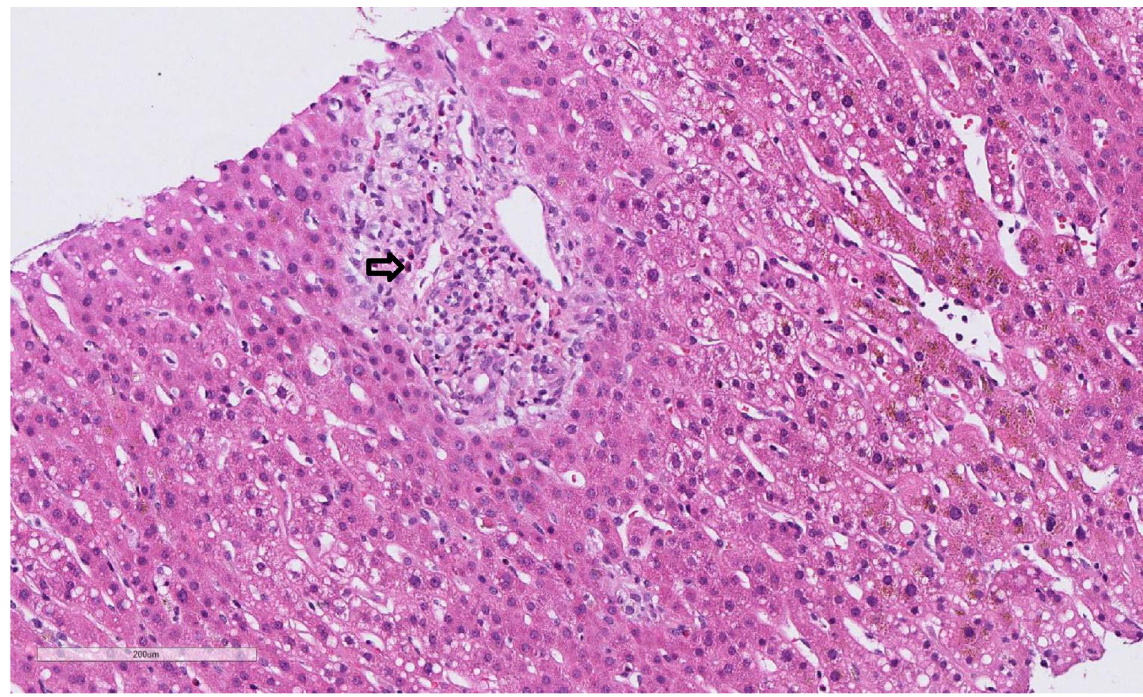
Figure 5. Case 4 liver biopsy: eosinophilic portal field infiltrate (arrow, hematoxylin-eosin,